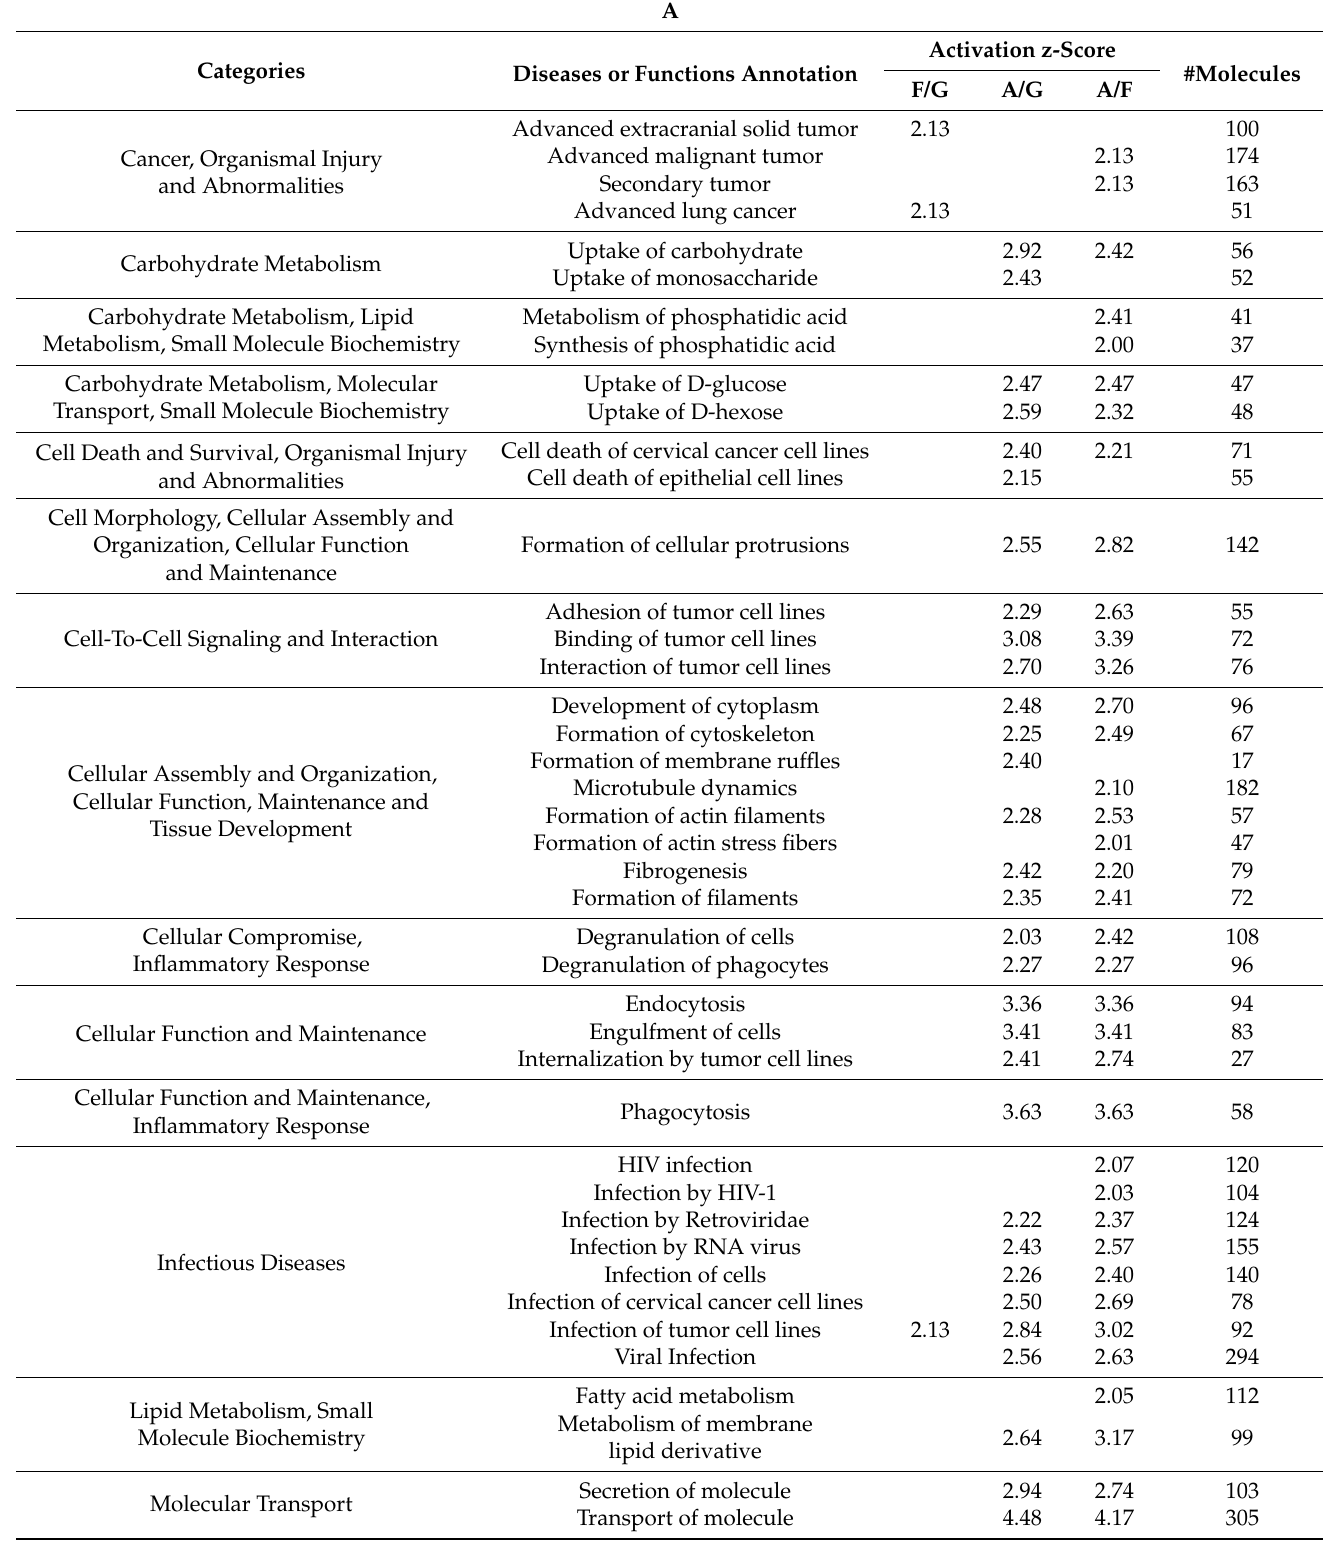
Table 1. ( A ) Pathways and gene clusters predicted to be upregulated by allulose perfusion compared to glucose and to fructose. ( B ) Pathways and gene clusters predicted to be downregulated by allulose perfusion compared to glucose and to